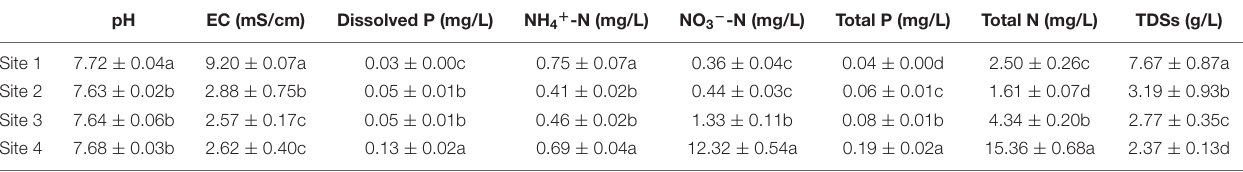
TABLE 2 | Groundwater properties of the four study sites.